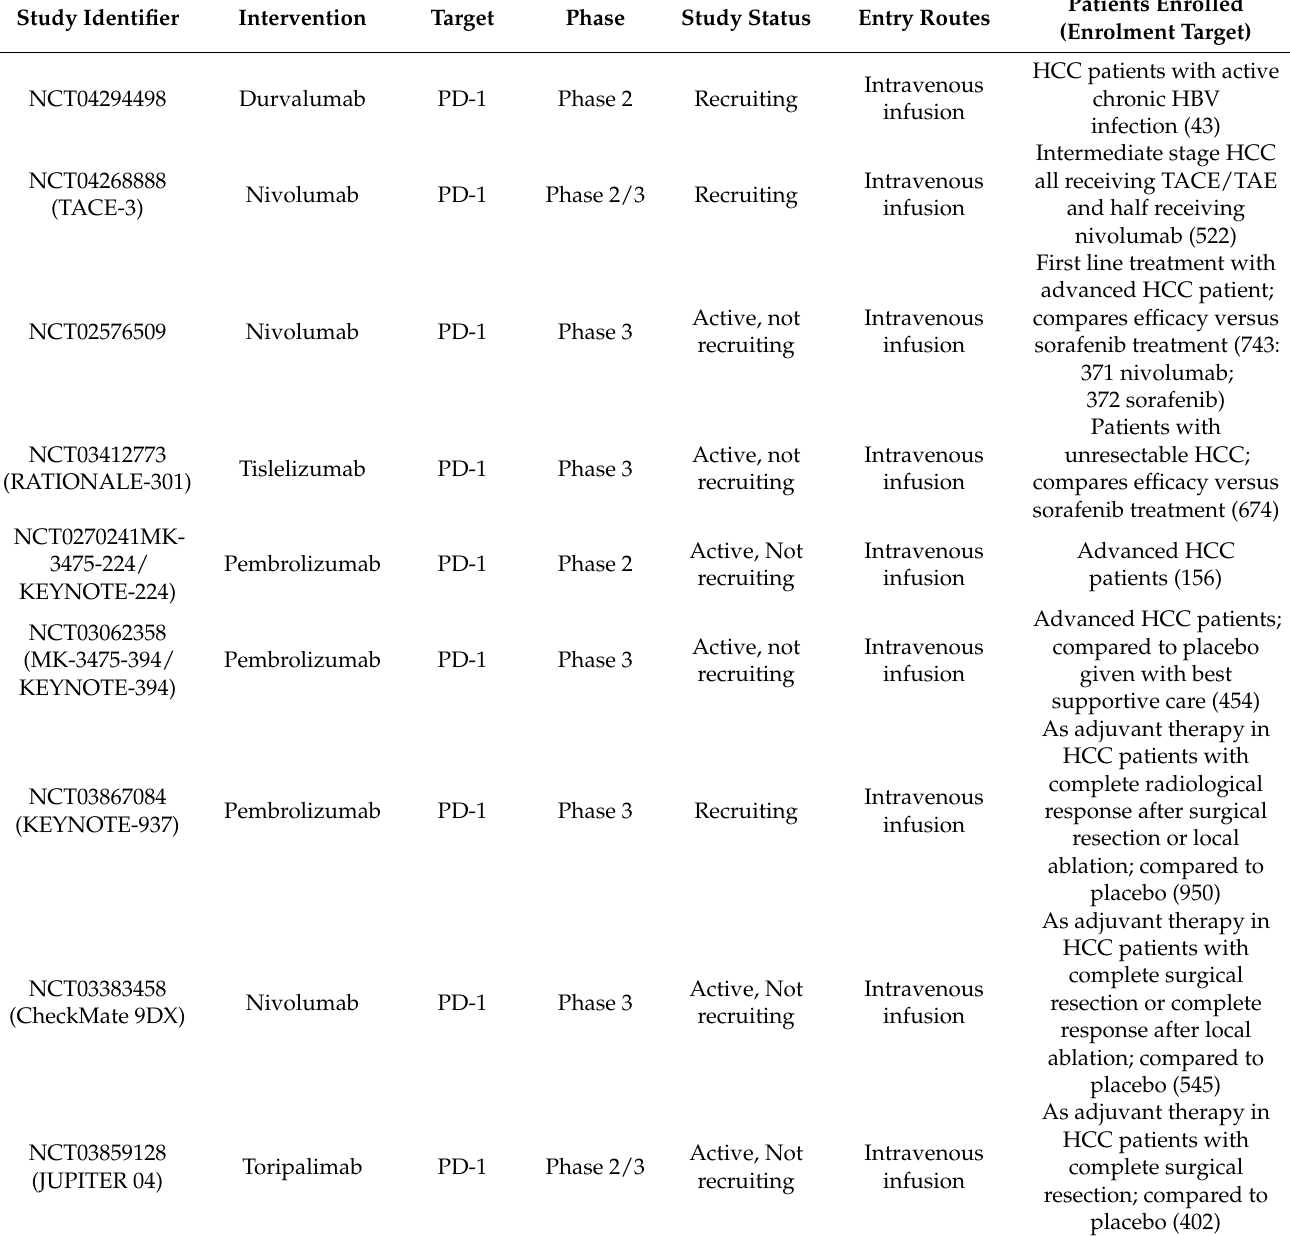
Table 3. Data from https://www.clinicaltrials.gov/ accessed on 10 May 2022 showing clinical trials of immunotherapy (immune checkpoint inhibitor monotherapy) for the treatment of advanced hepatocellular